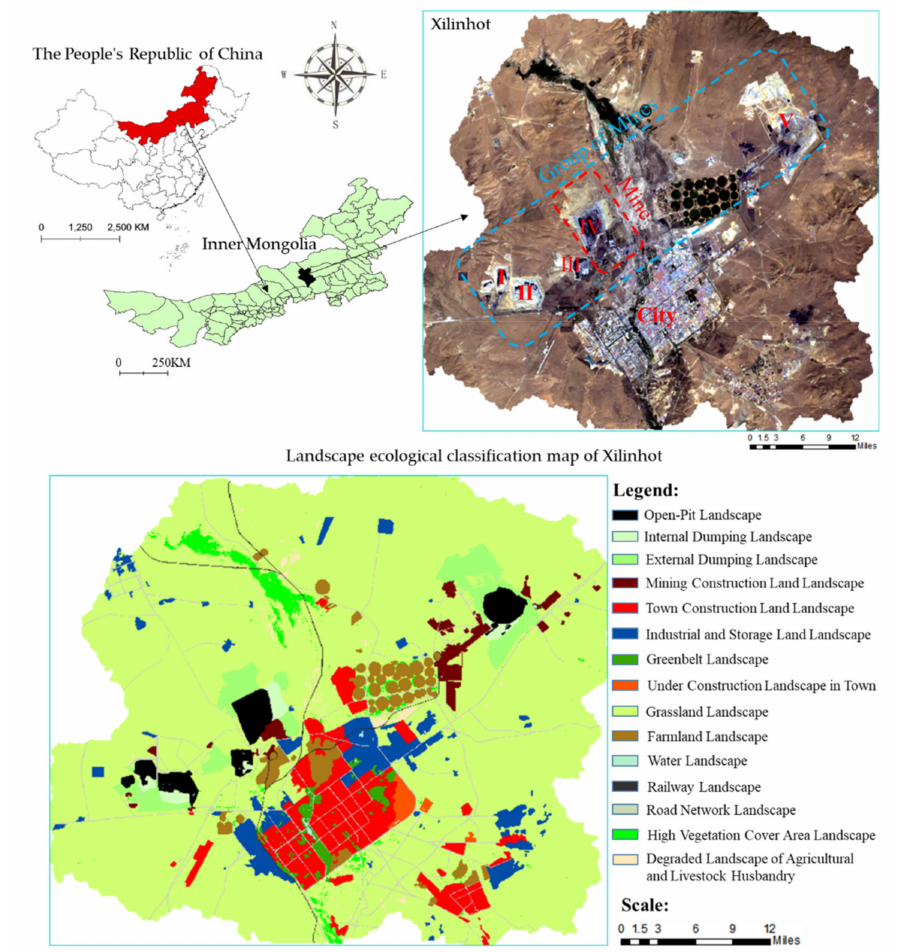
Figure 2. Location of the Research Area. I: Open-pit Germanium Mine; II: West No. 2 Open-pit Mine; III: West No. 3 Open-pit Mine; IV: No. 1 Open-pit Mine; V: East No. 2 Open-pit